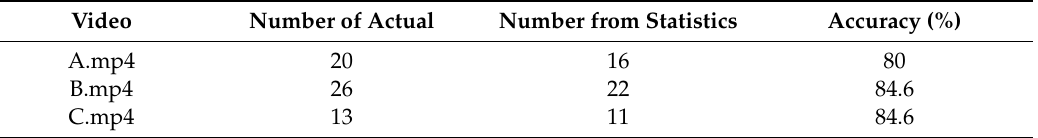
Table 5. YOLO video traffic monitoring statistics.